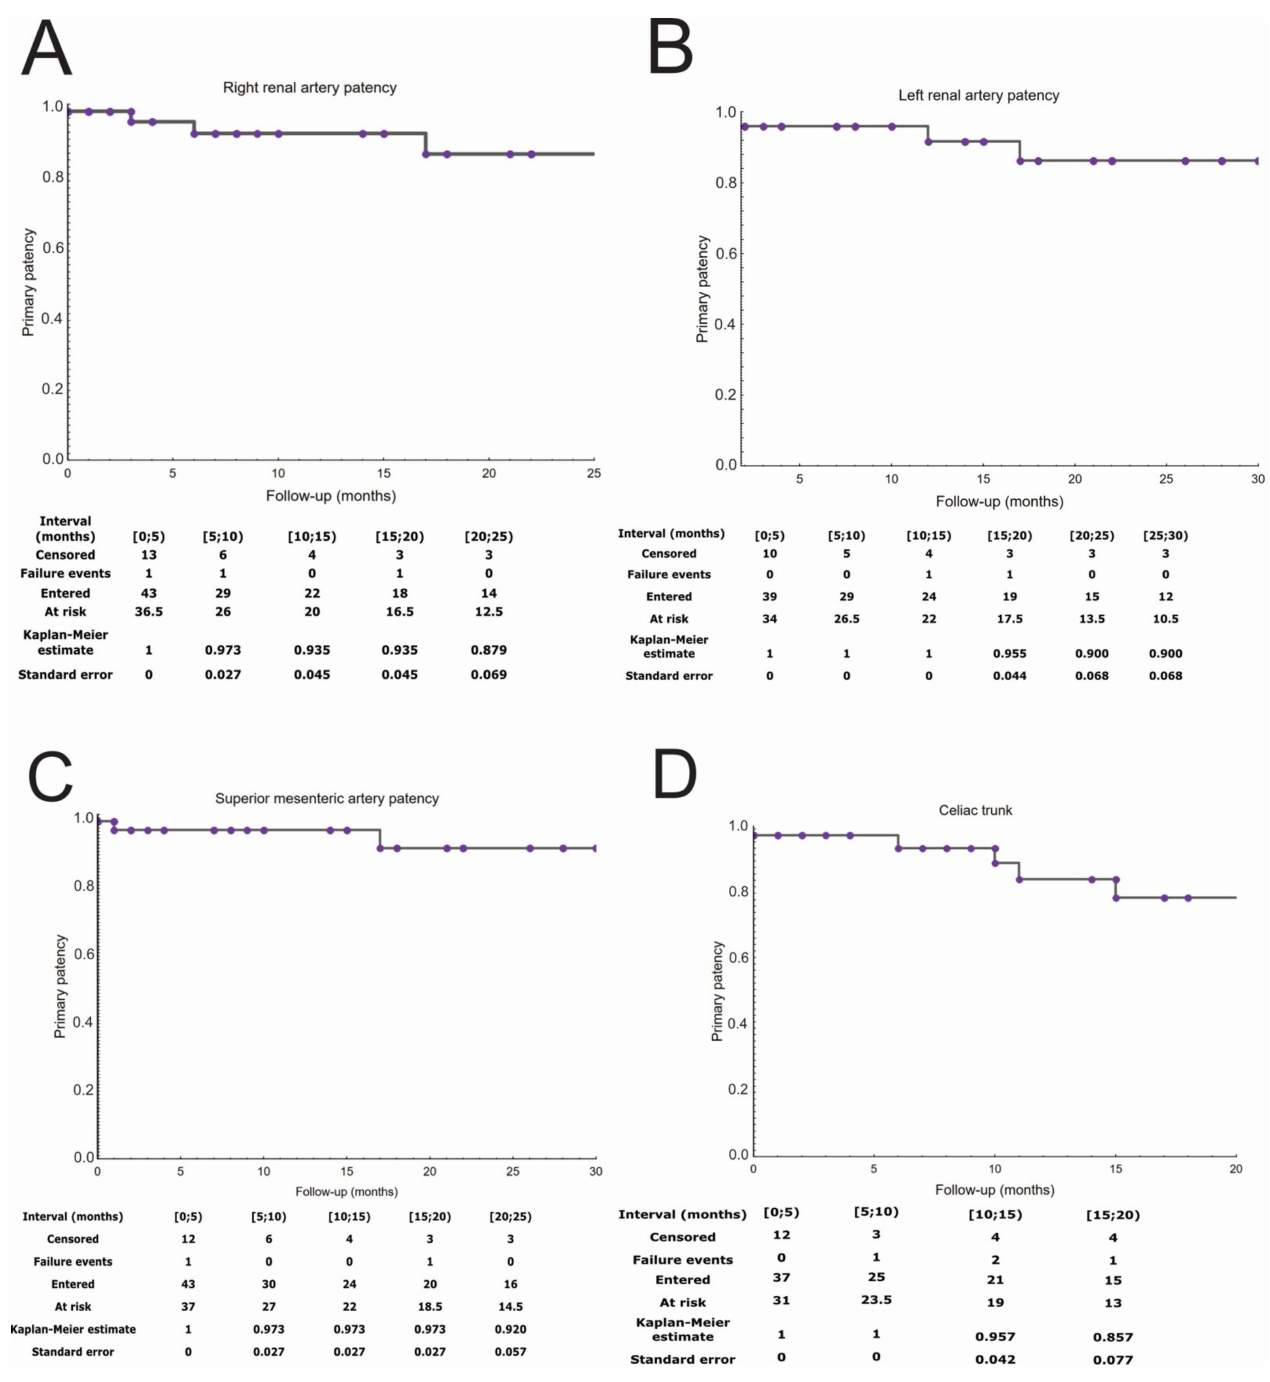
Figure 3. The target vessel patency rates are presented on Kaplan–Meier curves. Right renal patency ( A ). Left renal artery patency ( B ). Superior mesenteric patency ( C ). Celiac trunk patency ( D